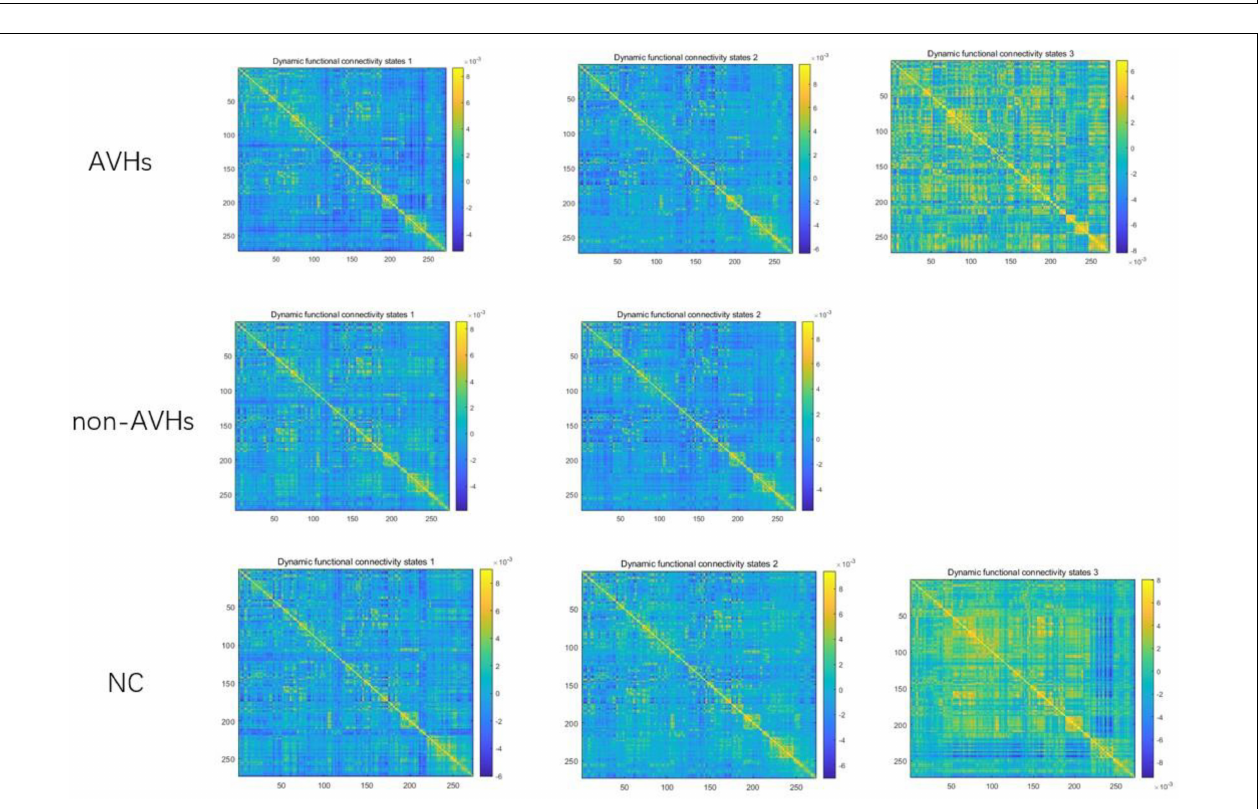
FIGURE 7 | Patterns of dynamic functional connectivity states in the AVHs, non-AVHs groups and NC groups without global signal regression (overlap = 0.6).